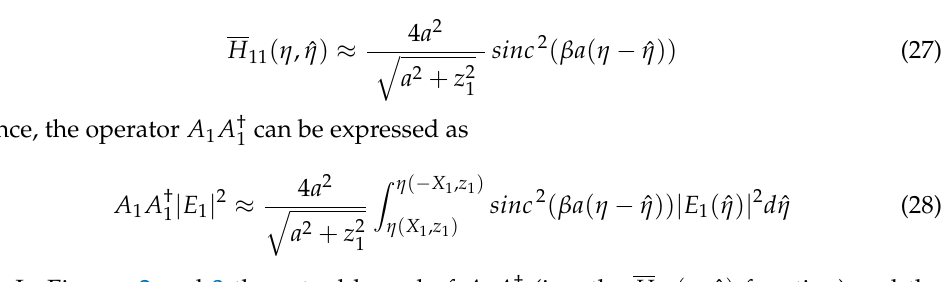
in dB for the configuration a = 20 λ , z o = 5 λ , X 1 = 5 a . 1